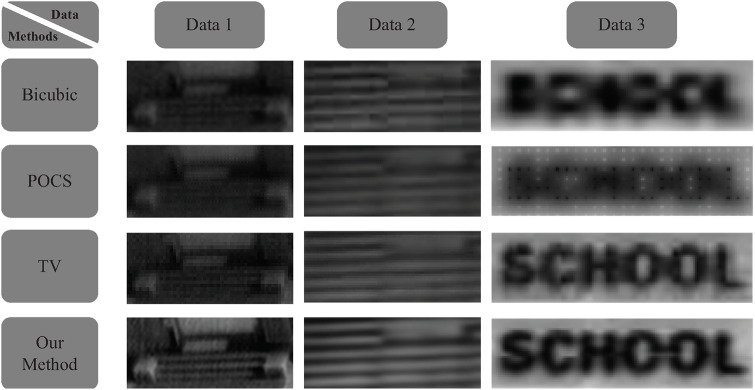
Performance comparison of different super-resolution results.